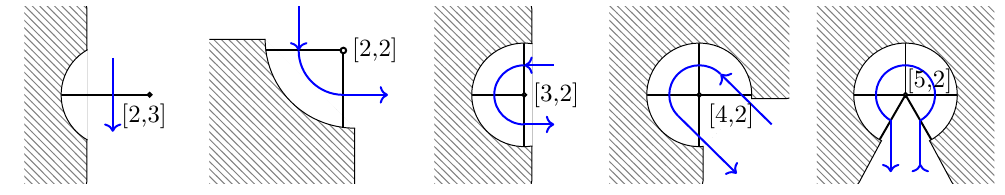
JHEP05(2018)003 (cid:25)= 2 we shift both (cid:6)